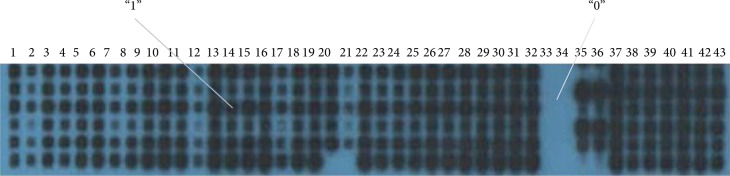
Spoligotyping fingerprints. Positive (interval existence) or negative (interval missing) hybridization results are represented by binary codes 1 and 0, respectively.